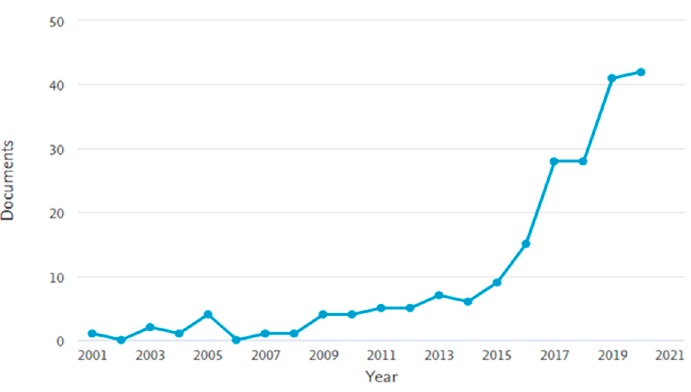
Figure 5. Trend of scientific publications from 2001 to 2020 reported by Scopus using as a query string: TITLE-ABS-KEY (plant AND by-products AND waste AND valorization).